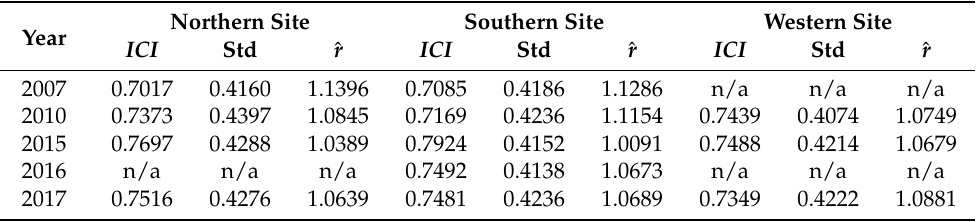
Table 4. Estimated mean interclick interval (ICI), standard deviation (std) and click production rates ( 𝑟̂ ) at three sites for each survey year.